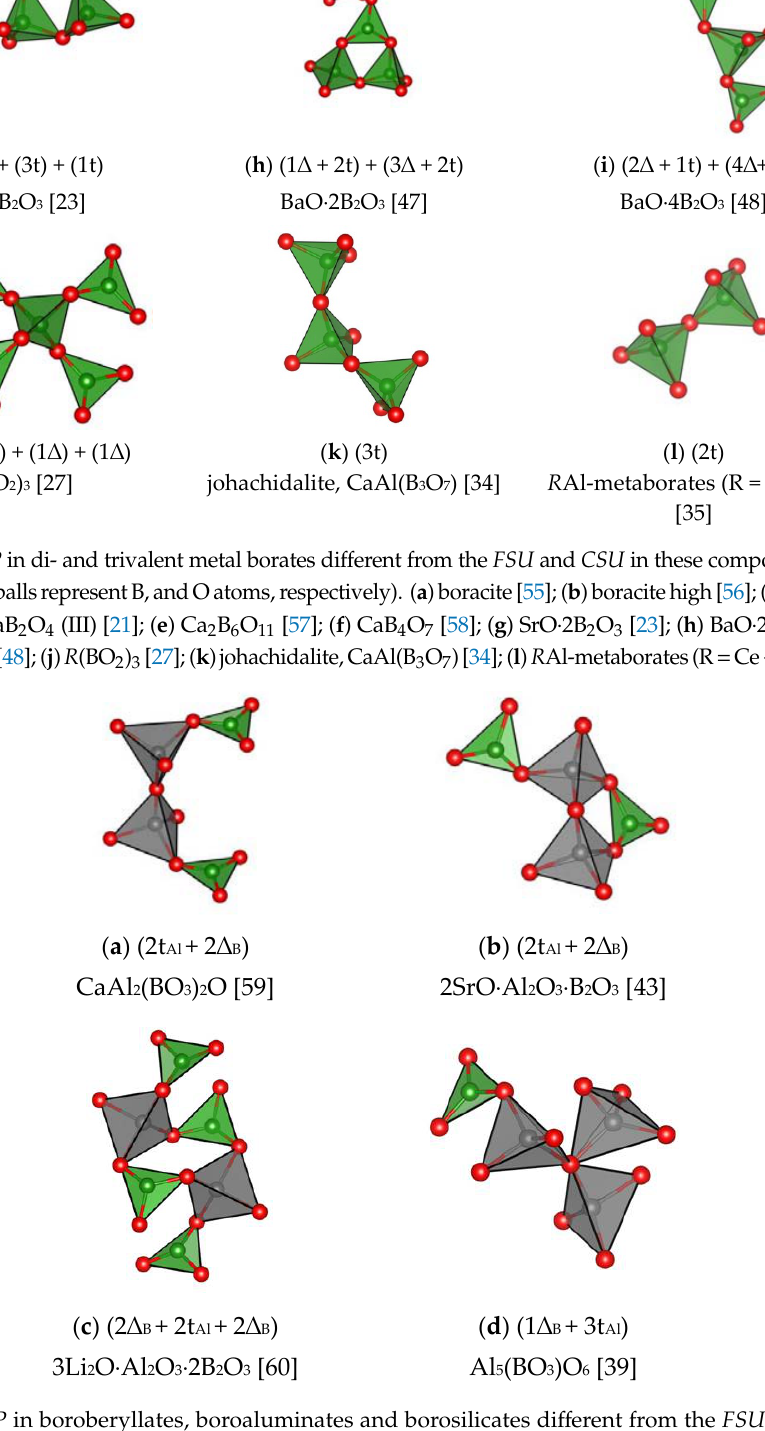
Figure 8. CRP in boroberyllates, boroaluminates and borosilicates di ff erent from the FSU and CSU in these compounds (the green, grey, and red balls represent B, Al and, O atoms, respectively). ( a ) CaAl 2 (BO 3 ) 2 O [59]; ( b ) 2SrO · Al 2 O 3 · B 2 O 3 [43]; ( c ) 3Li 2 O · Al 2 O 3 · 2B 2 O 3 [60];( d ) Al 5 (BO 3 )O 6